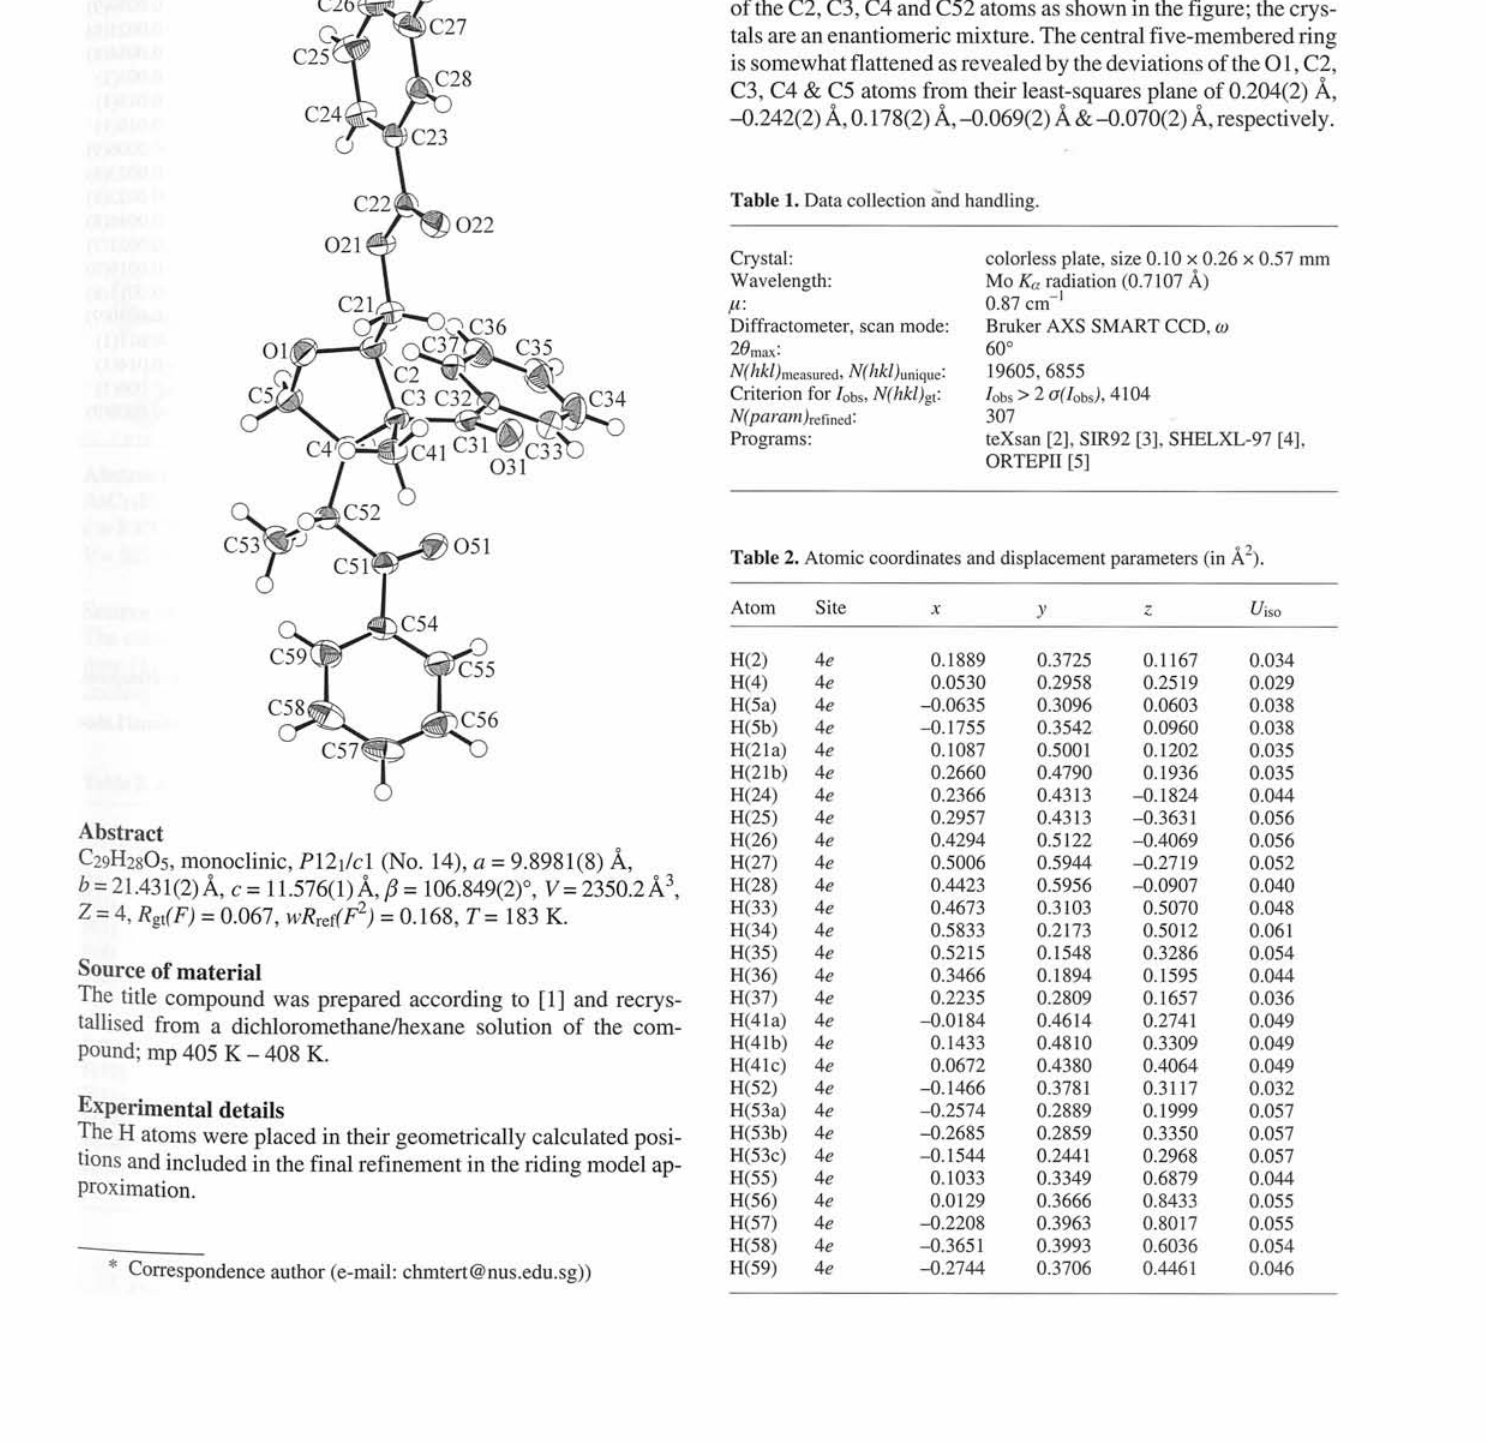
Table 1. Data collection and handling. Crystal: Wavelength: μ: Diffractometer, scan mode: